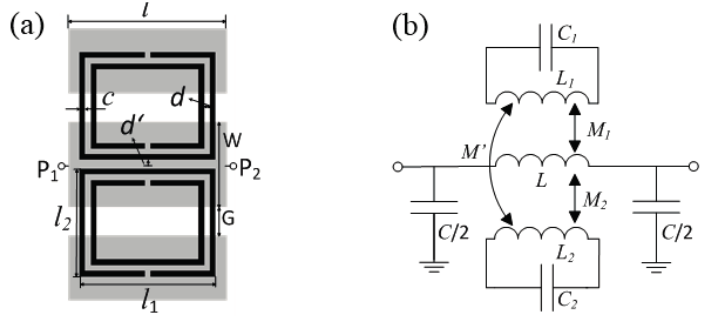
Figure 13. Typical topology of a CPW loaded with a pair of SRRs ( a ), and lumped element equivalent circuit model, considering magnetic coupling between SRRs ( b ). The model considers the general case of different SRRs, or identical SRRs with different dielectric loading (in the latter case, L 1 = L 2